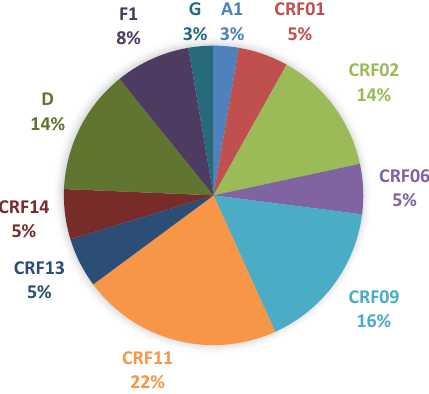
Figure 3. Distribution of virus subtypes in 37 patients with virological failure in Chad.